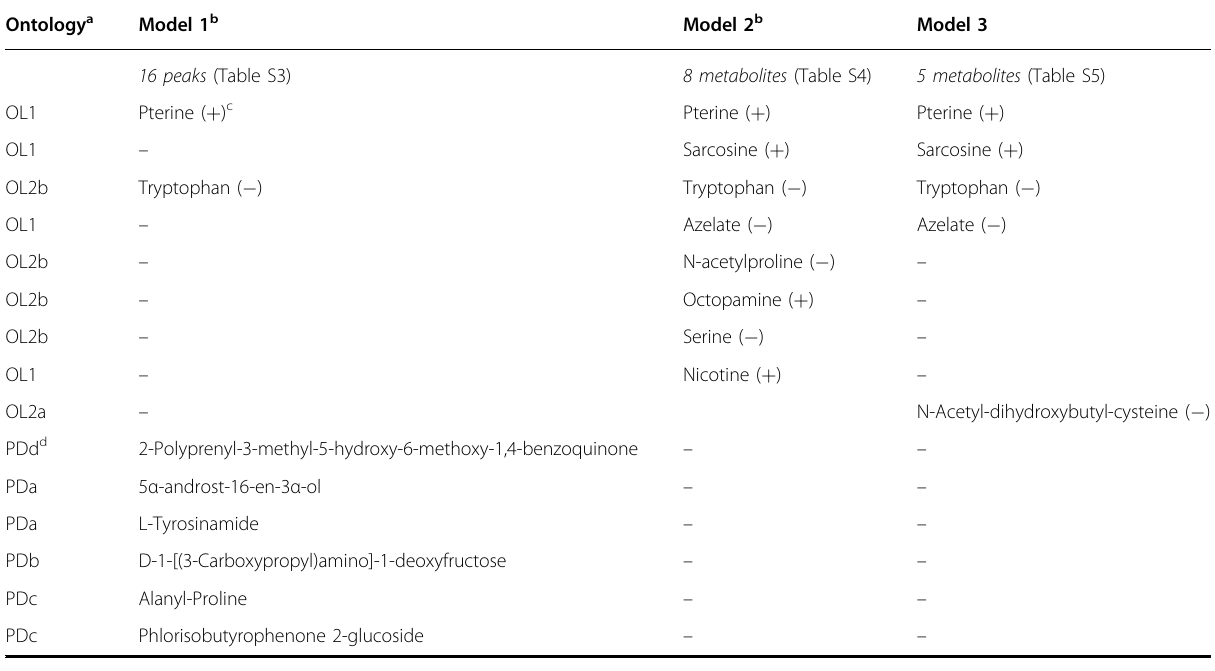
Table 3 Metabolites predictive of a positive OUD diagnosis in high opium users. Ontology